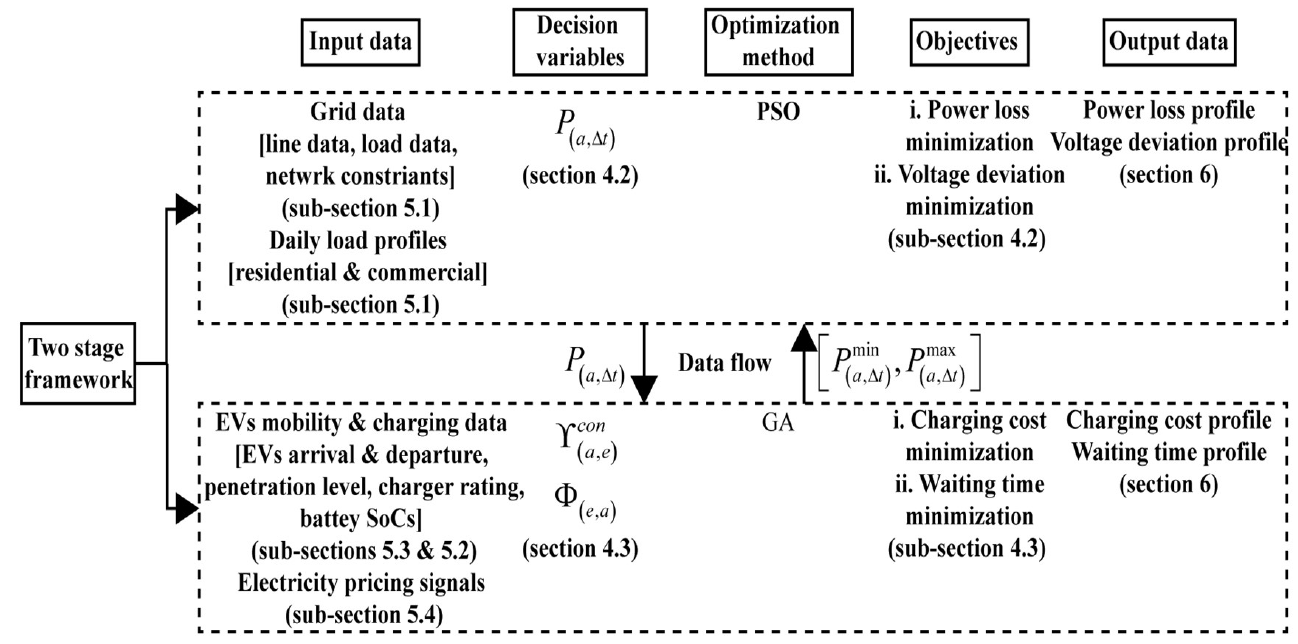
Figure 2. Proposed research design.